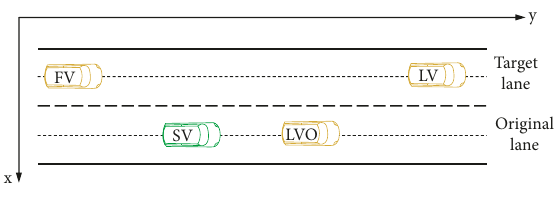
Figure 2: A lane-changing